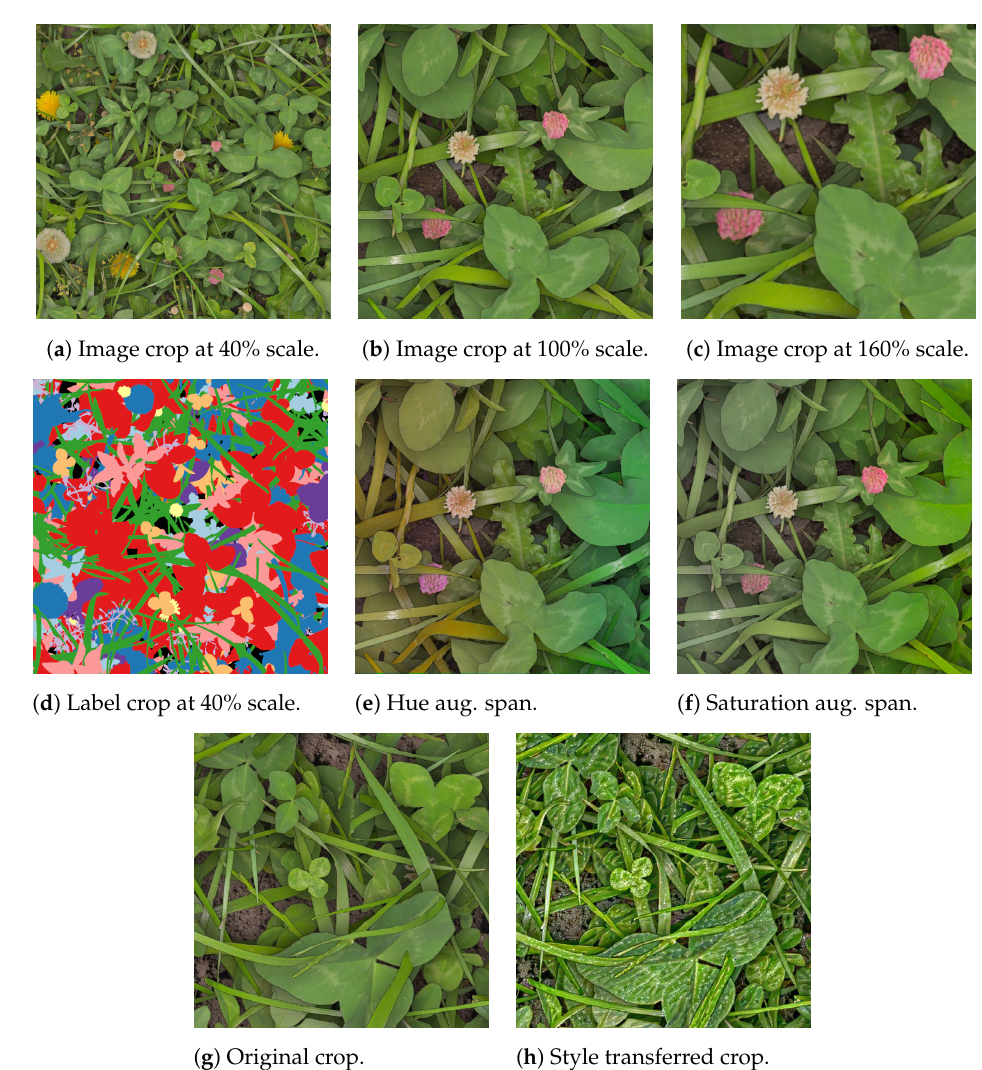
Figure 5. Illustration of image augmentations applied on the synthetic image crops during training of the model. ( a – f ) represent online augmentations throughout the training process; ( g , h ) represent style transfer of dew artifacts, used for offline-augmentation of synthetic images in subsequent fine-tuning of the 1st stage